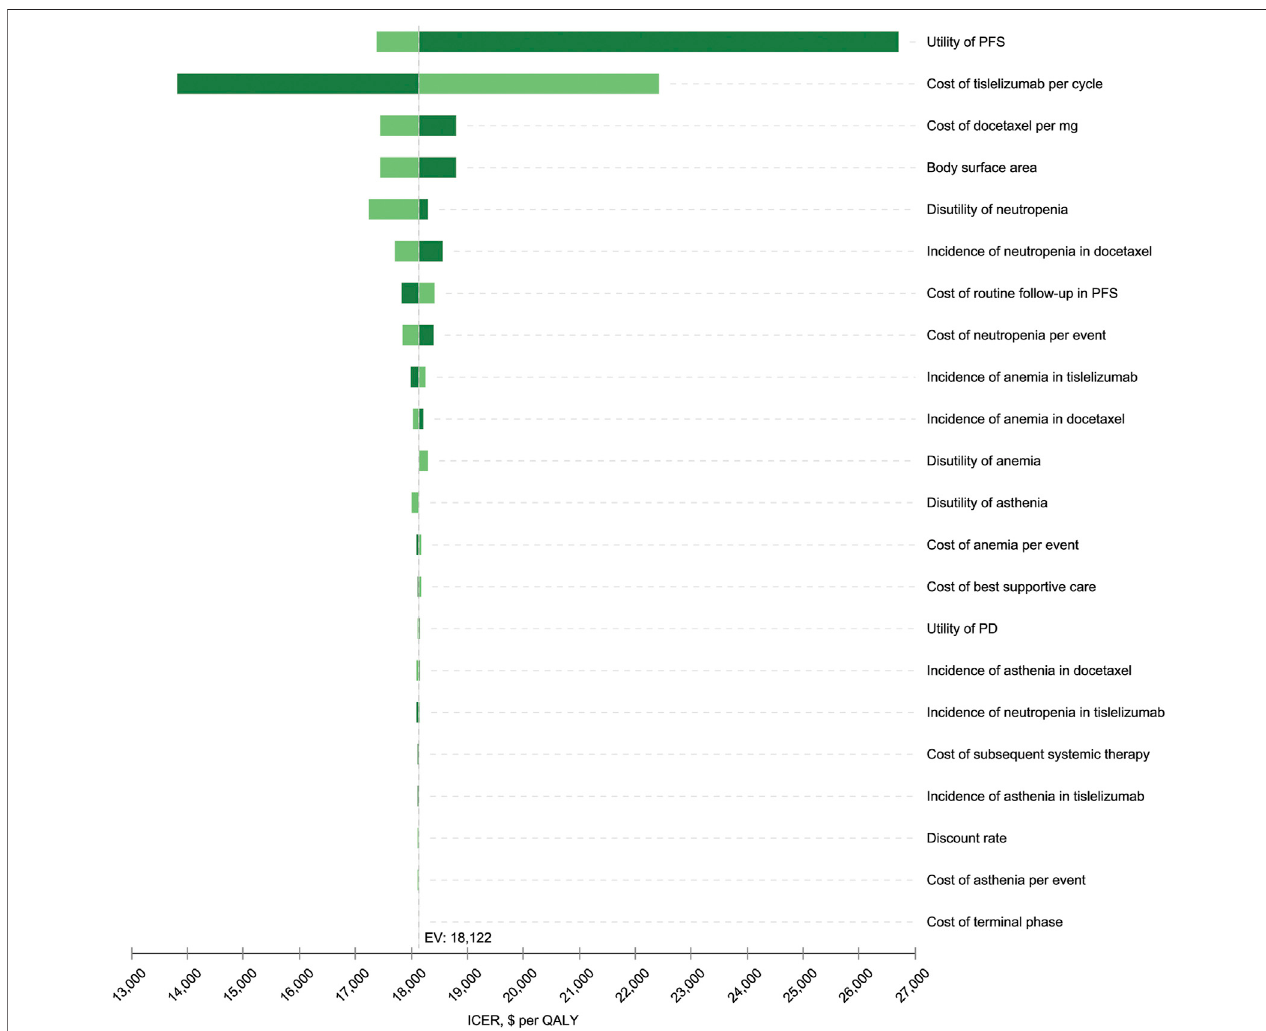
FIGURE 2 | Tornado diagram for the one-way sensitivity analysis. The variables are listed in descending order by their in fl uence on the ICER. The dashed line intersectingthebars represents theICER of$18,122perQALY fromthebase-caseresult.PFS,progression-free survival;PD,progressivedisease; EV,estimatedvalue; ICER, incremental cost-effectiveness ratio; QALY, quality-adjusted life